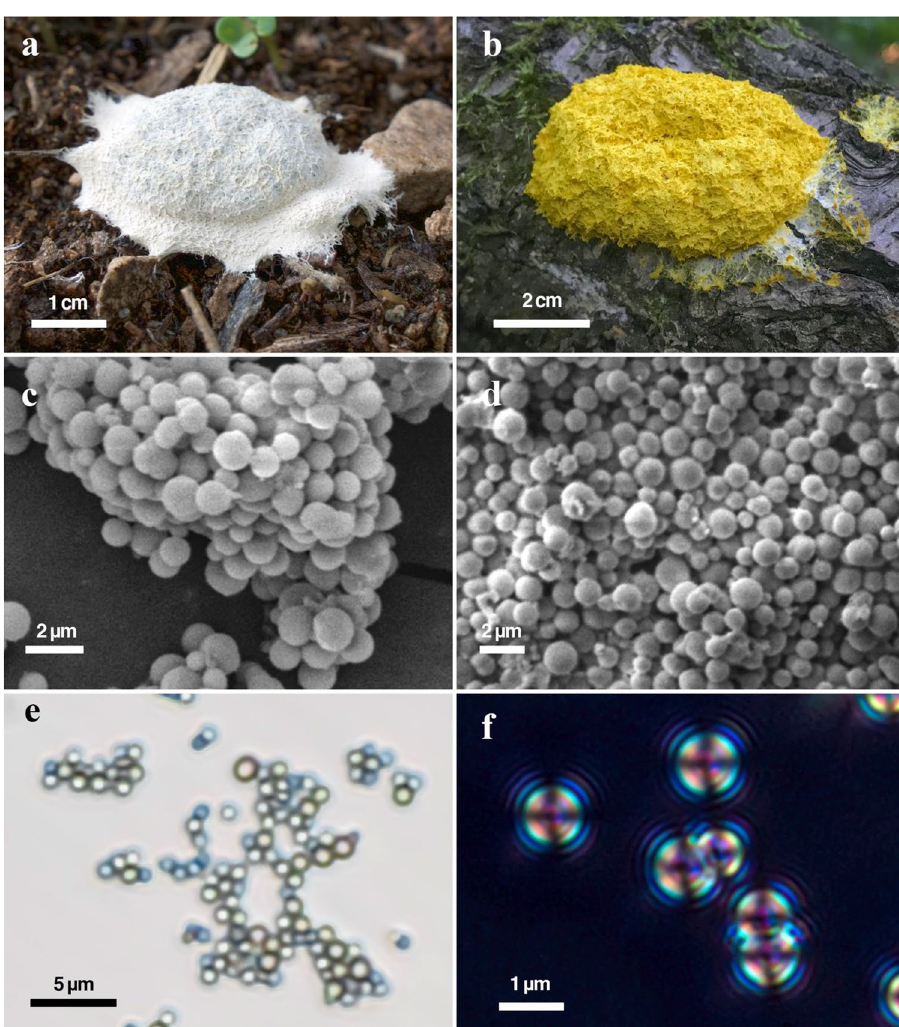
Figure 1. Photographs of Fuligo septica aethalia of ( a ) typical Arizona specimen (FSW), and ( b ) yellow specimen from the UK (FSY), and corresponding BSE SEM images of the peridium ( c , d ) showing the spherical morphology of the peridial HACC. ( e ) Optical transmitted-light microscope image of a cluster of HACC spheres, and ( f ) crossed-polarized transmitted-light optical image of the spheres. The spheres show dark isogyres and isochromatic rings characteristic of an amorphous material.